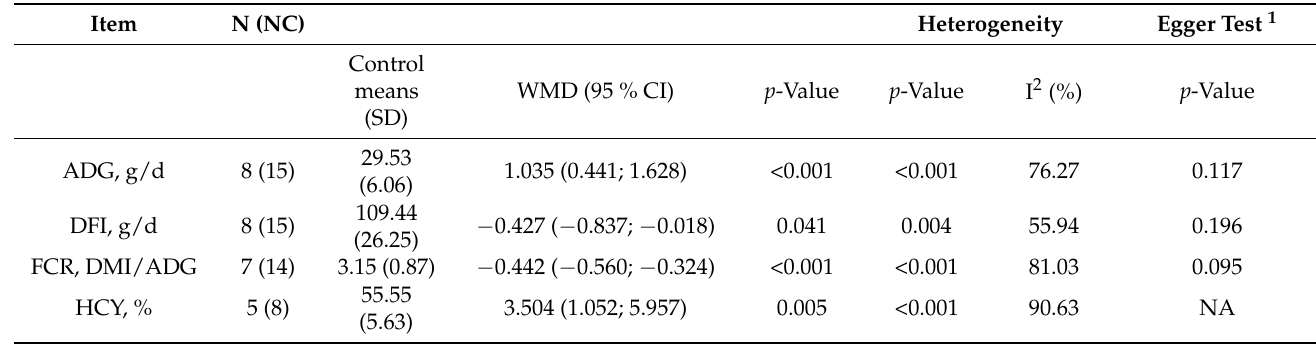
Table 3. Growth performance of rabbits supplemented with